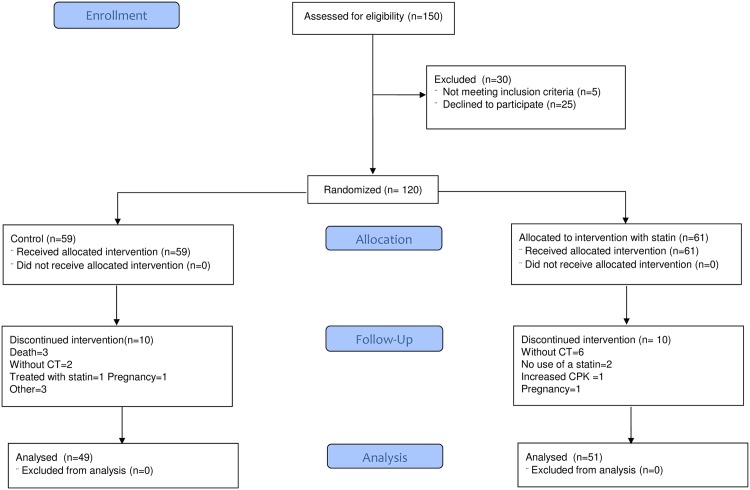
Patient distribution.